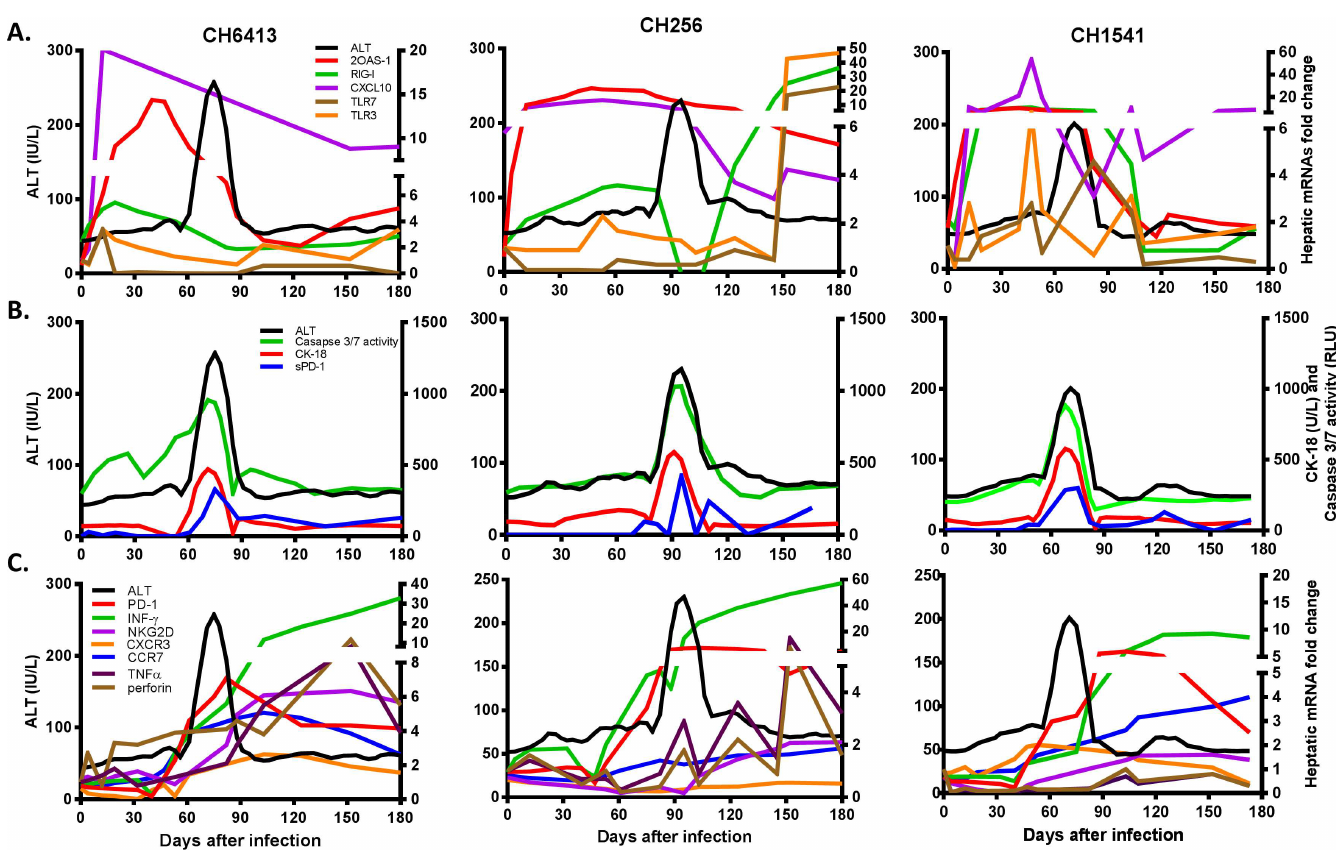
Fig 4. Smoothed trajectoriesof each hepatic mRNA expression compared to ALT activity during acute HCV infection. Hepatic expression of mRNAs was up-regulated before the peak (A), at the peak (B), and after the peak of ALT